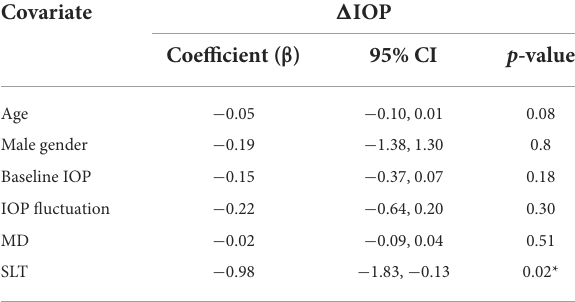
TABLE 3 The influence of planning SLT treatment on 1 IOP in the SLT